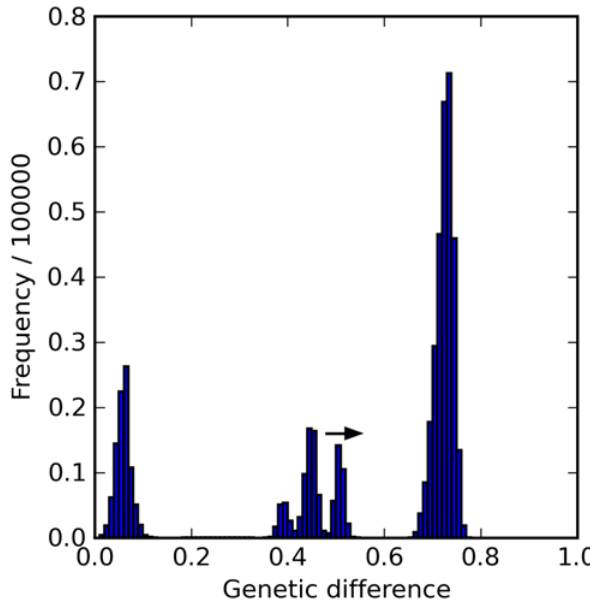
Figure 3. Example of a Mismatch Distribution. Shown are the frequencies of genetic distance classes between 500,000 randomly sampled pairs of haploid genomes. The multimodal distribution evident in this example indicated the existence of more than one distinctive gene pool in the population. The data here were drawn from generation 120,000 in a run where individuals contained n =2 diploid chromosomes of l =200 base pairs each, grid size was 400 6 400, population size was 128,000, maximum occupancy was 1 individual per cell, movement distance d =1.5, and mutation rate m =0.00005 per site per replication. Offspring viability dropped to 0 beyond a genetic distance of h =0.6. The presence of a distinct peak to the right of this threshold indicated the presence of reproductively incompatible populations. The peak to the far right never moved much beyond a genetic difference of 75%, the maximum value expected under the Jukes-Cantor mutation model [33]. The peak to the far left was also unmoving and remained centered near a genetic difference of h 0 =0.05. This peak included all within-subpopulation comparisons. Peaks between these extremes always moved to the right; some eventually merged with the peak on the right, but most vanished first, indicating extinction of one or both subpopulations compared within the